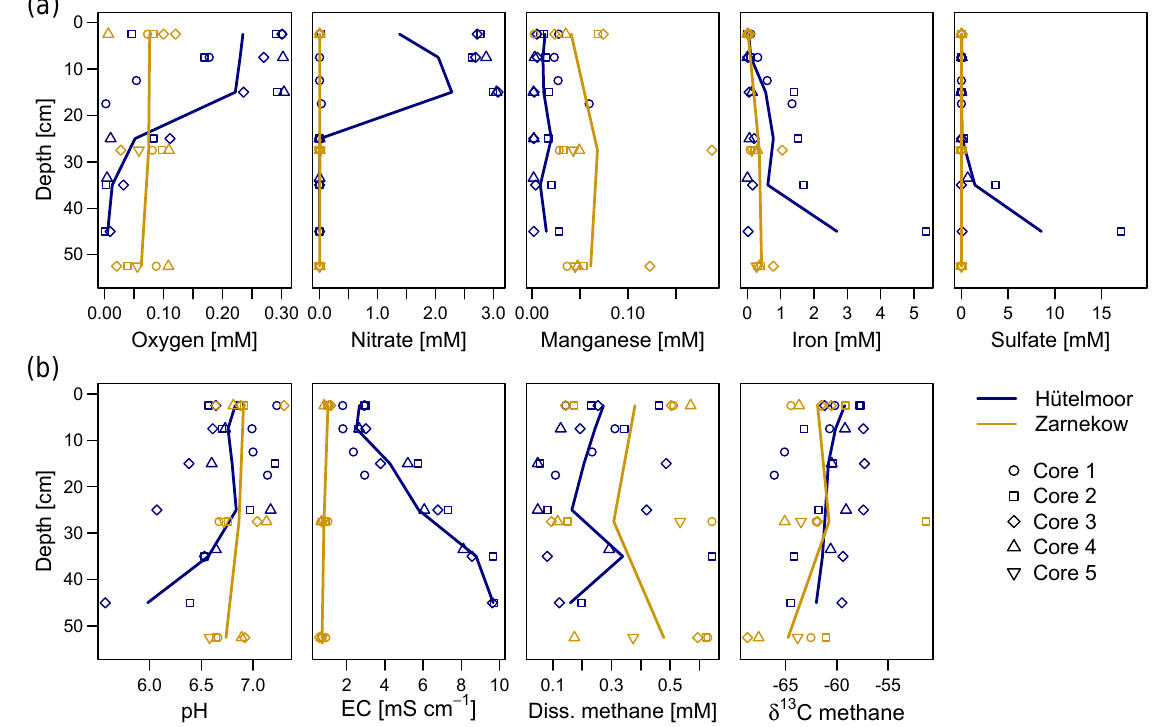
Figure 2. Depth profiles of oxygen, nitrate, total iron, manganese, and sulfate (a) , and profiles of pH, EC, dissolved methane, and the isotopic signature of methane-bound carbon (b) in both study sites. Solid lines connect the respective means of individual wetlands ( n = 4 for Hütelmoor and n = 5 for